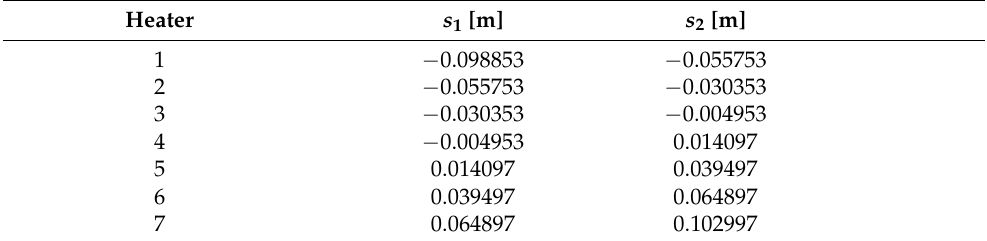
Table 2. Location of the heaters in terms of starting ( s 1 ) and ending ( s 2 ) curvilinear abscissas.